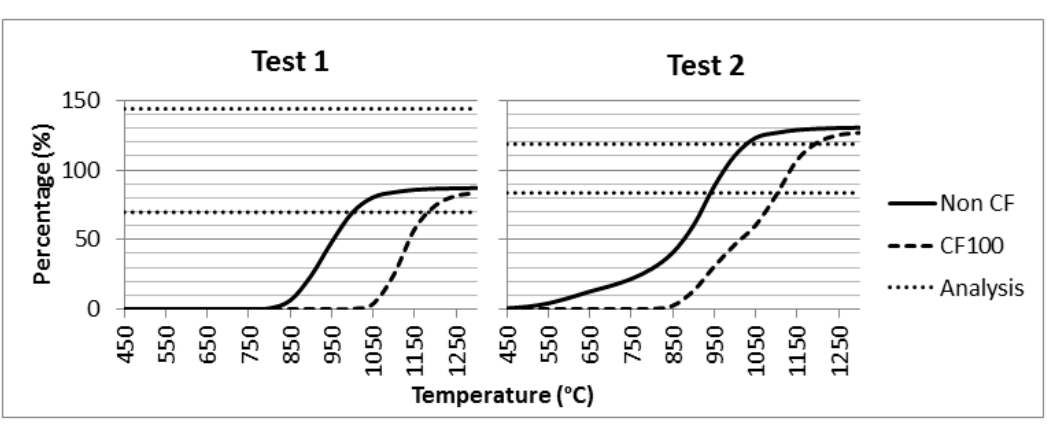
Figure 7. Comparison between the predicted SO 2 concentrations in the flue gas from the simulations carried out using the GE and IE models and the experimental ones obtained onsite.